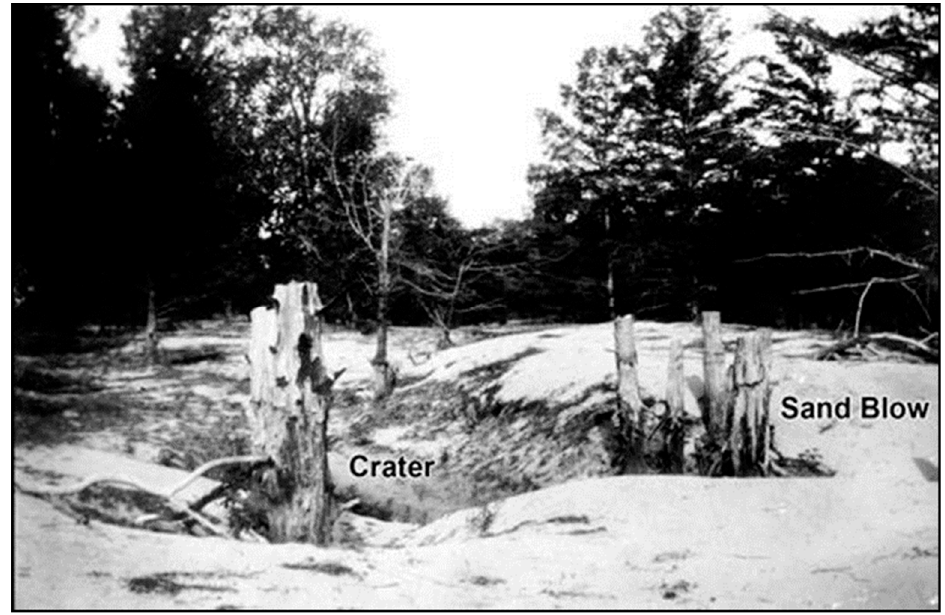
Figure 1. Photograph of large sand blow that formed as the result of liquefaction during the 1811–1812 New Madrid earthquake sequence [36].